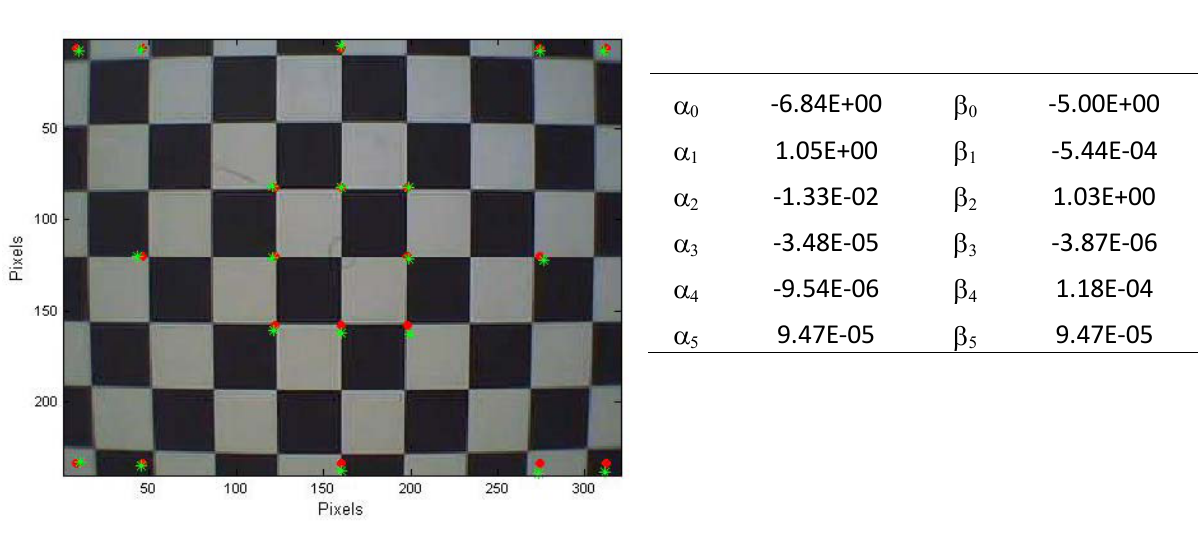
Figure 4. Warping results with the values of the warping equation's parameters. Red dots are the correct position and green stars are the